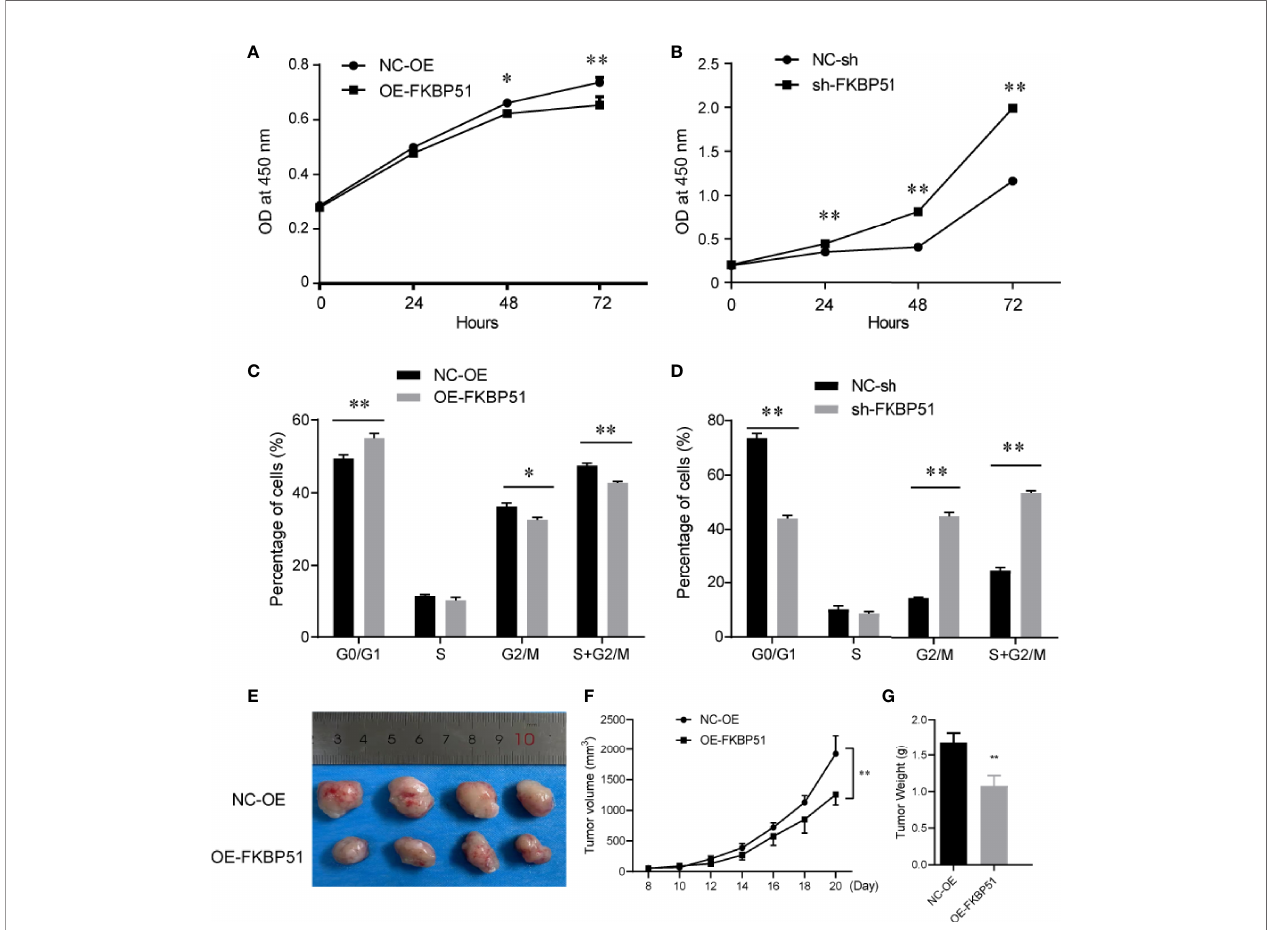
FIGURE 2 | FKBP51 suppresses the cell cycle progression and proliferation of AML-M5 cells both in vitro and in vivo (A, B) In the CCK-8 cell proliferation assays, the upregulation of FKBP51 suppressed the growth rate of AML-M5 cells (A) , while downregulation had the opposite effect (B) . (C, D) Overexpression of FKBP51 resulted in a decrease in the G2/S ratio in AML-M5 cells (C) , while downregulation had the opposite effect (D) . (E) up-regulation of FKBP51 decreased tumor growth in vivo . Top, tumors from the control cells after 3 weeks of implantation; bottom, tumors from cells with stable overexpression of FKBP51. Images were photographed at the time of grafted removal (day 21). (F, G) The weight and volume of tumors from the FKBP51overexpression cells were signi fi cantly lower than those from the control cells (p < 0.01). All data are shown as the means ± SD. *p < 0.05, **p <